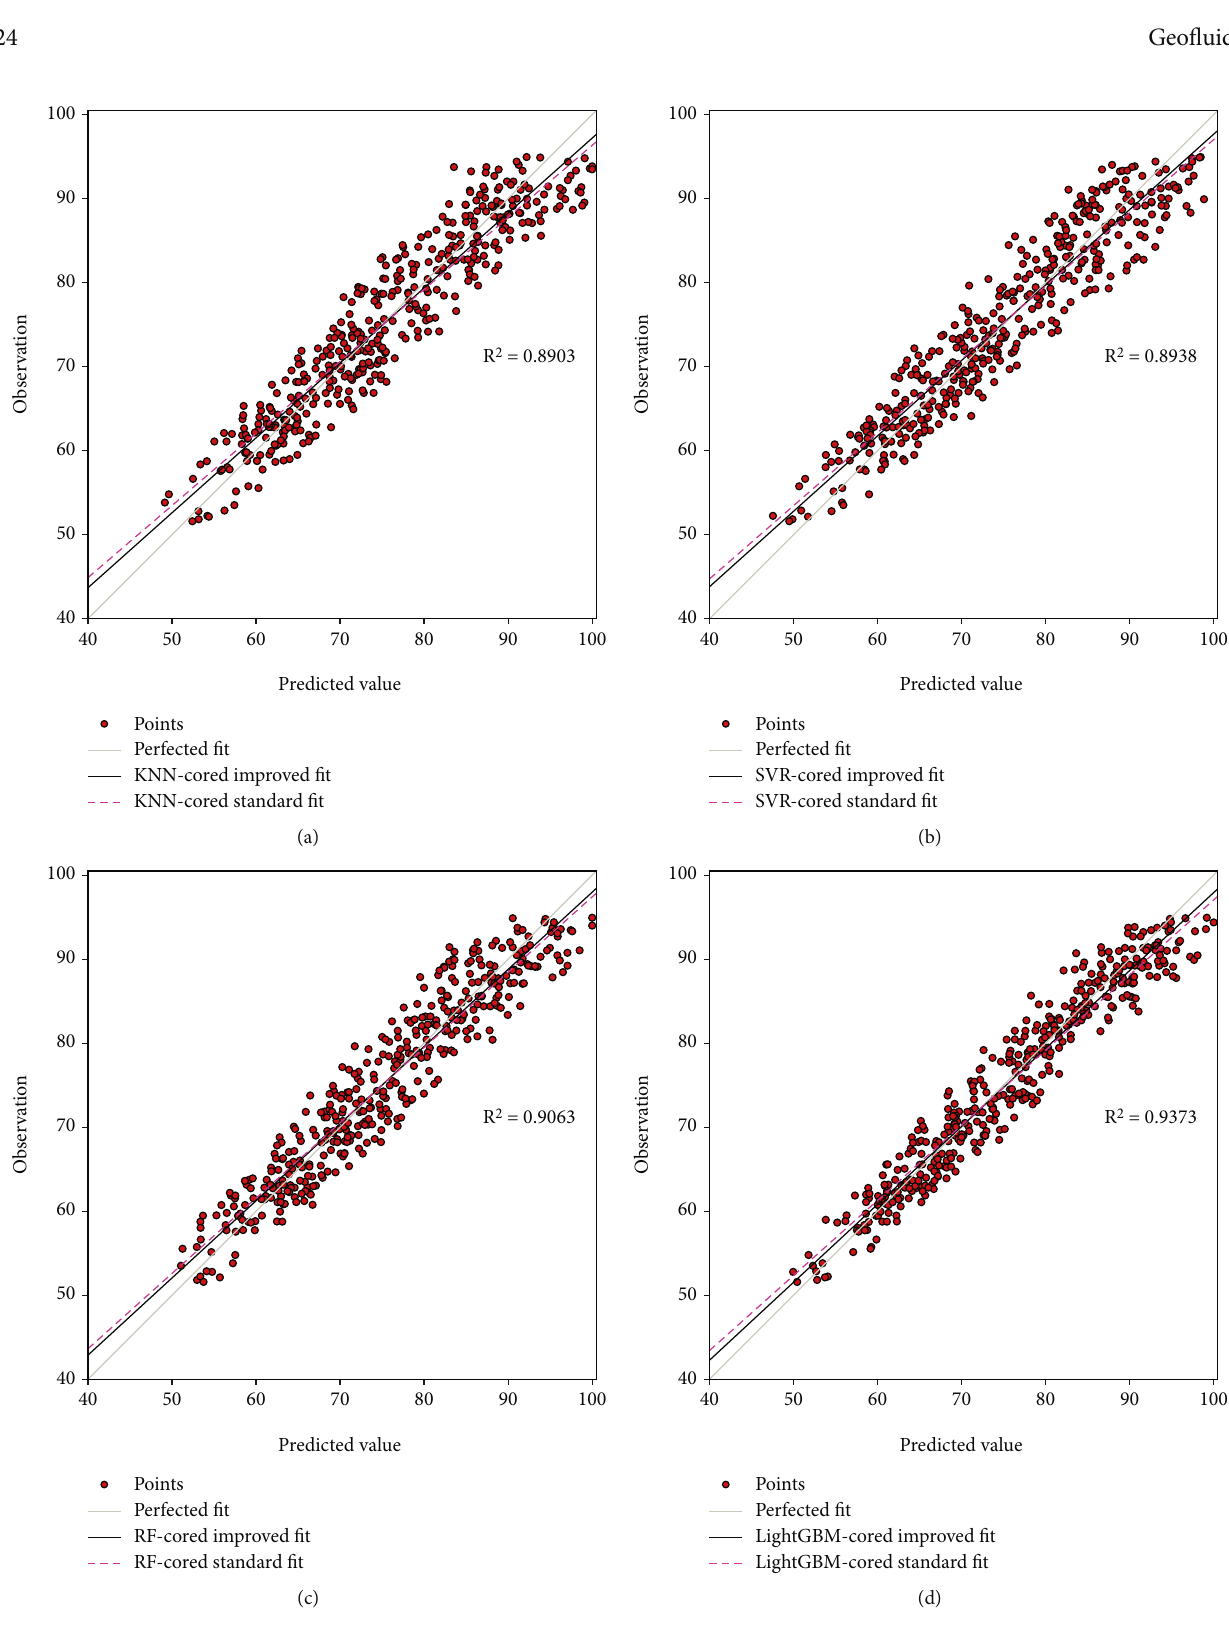
Figure 14: Fitness of water saturation results provided by KNN-cored predictor (a), SVR-cored predictor (b), RF-cored predictor (c), and LightGBM-cored predictor (d) in the second experiment. “ standard fi t ” means the fi tting is gained in the fi rst experiment; KNN =k-nearest neighbors; SVR =support vector regression; RF =random forest; LightGBM=light gradient boosting machine; RMSE =root-mean-square